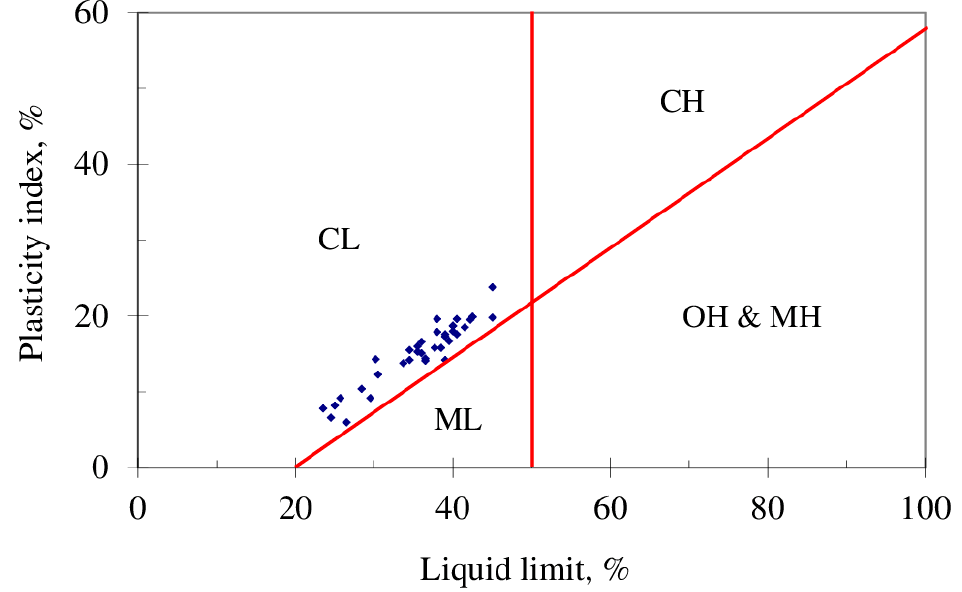
Figure 4. Location of the limits of consistency in the plasticity chart.